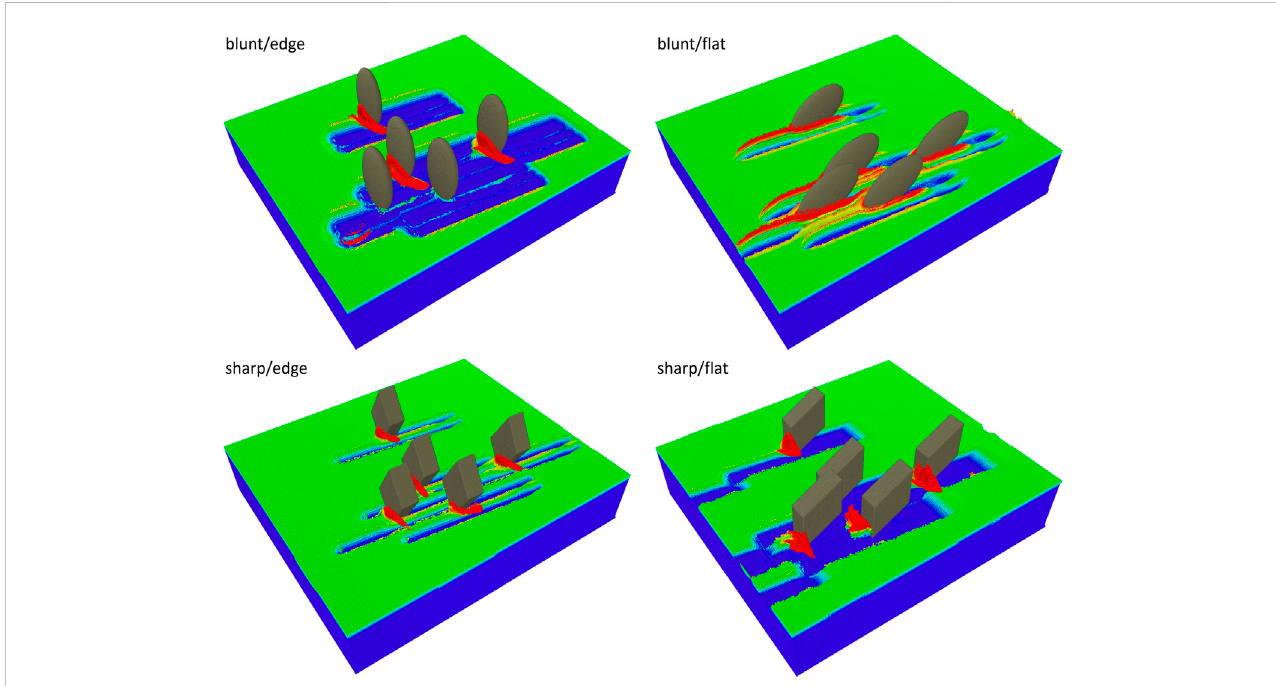
FIGURE 6 3D visualizations of the four con fi gurations (sharp and blunt abrasives in fl at and edge orientations) used for the pseudo-periodic multi-abrasive MPM simulations. Since we had to work around periodic boundary conditions, the ghost-versions of the two abrasives exiting the simulation box during each simulation run are explicitly modeled, making a total of 5 abrasives. The infeed depth was 5 μ m in all simulations, and the snapshots were taken after the fi rst grinding